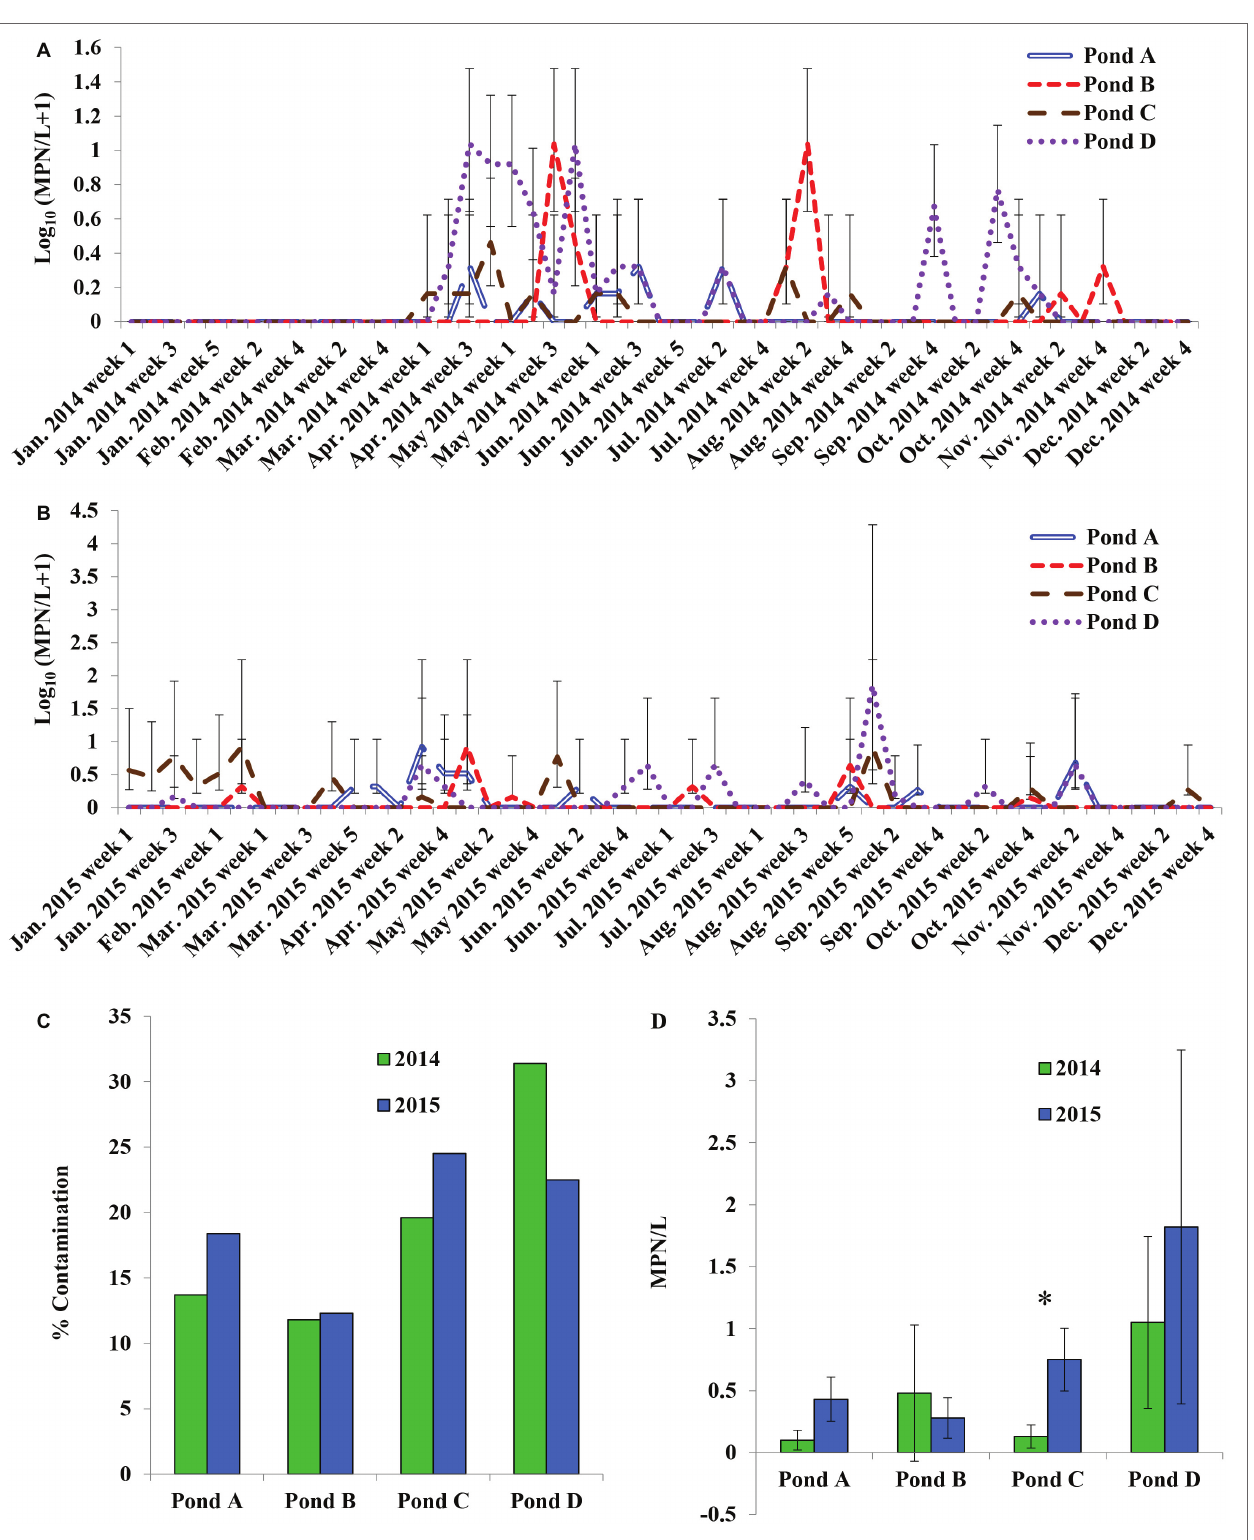
FIGURE 1 | Prevalence and most probable number (MPN) values of Salmonella enterica in pond irrigation water of four tested farms on the Eastern Shore of Virginia (ESV). (A) Weekly sampling in 2014; (B) weekly sampling in 2015; (C) comparison of Salmonella average prevalence in ponds in both years; (D) comparison of average population density in ponds in both years. Bars represent 95% confidence interval in (A) and (B) and represent standard errors in (D) . *Significant difference between two sampling years ( p <